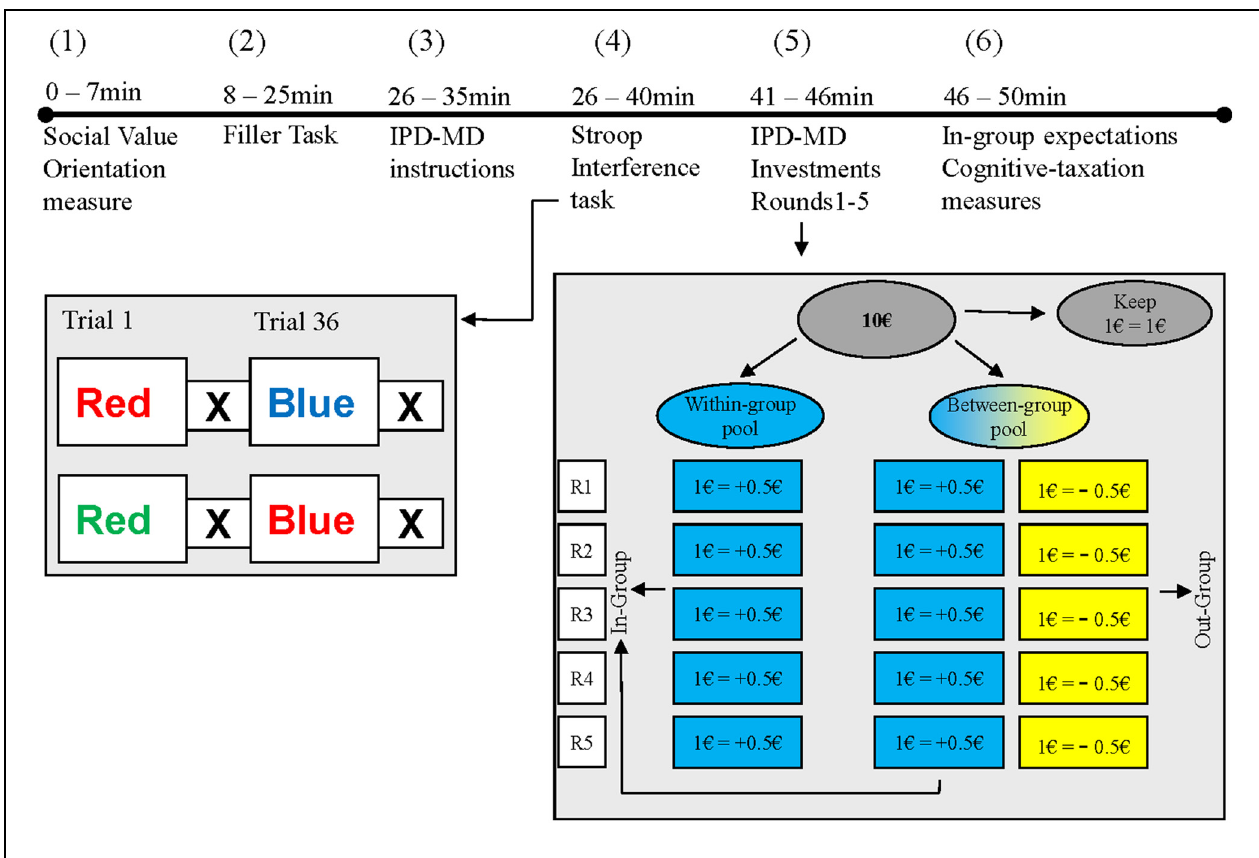
FIGURE 1 | Overview of experimental procedures and timeline. Following assessment of (1) social value orientation using nine decomposed games, subjects (2) completed irrelevant filler-tasks, were (3) organized in two three-person groups and explained the IPD–MD, before they (4)